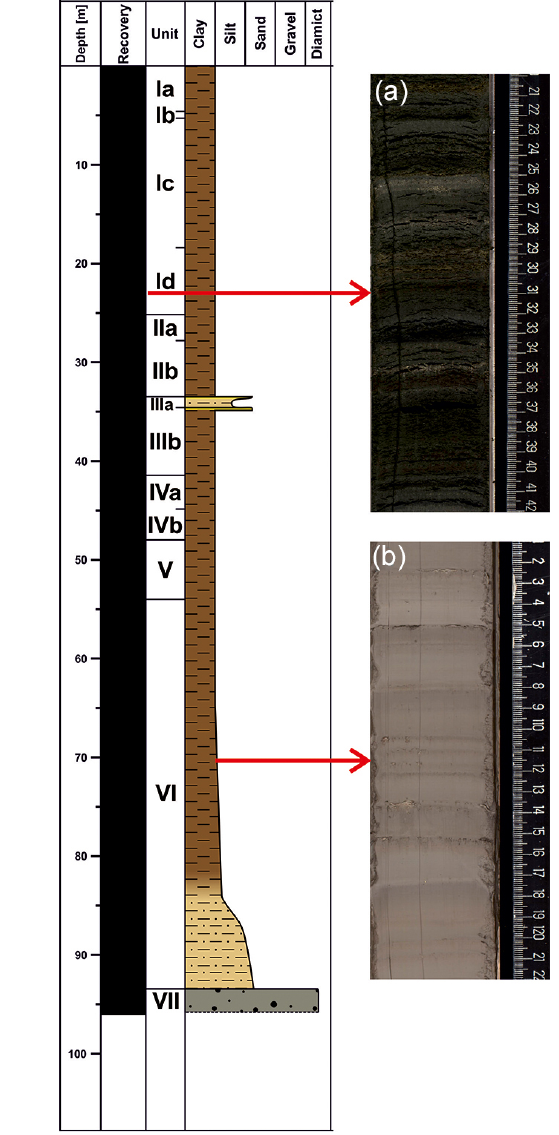
Figure 5. Landsort Deep, site M0063. Lithostratigraphy with insets (a) laminated Littorina Sea mud (section 347-M0063C-12H-2) and (b) varved Baltic Ice Lake glacial clay (section 347-M0063C-34H- 2).